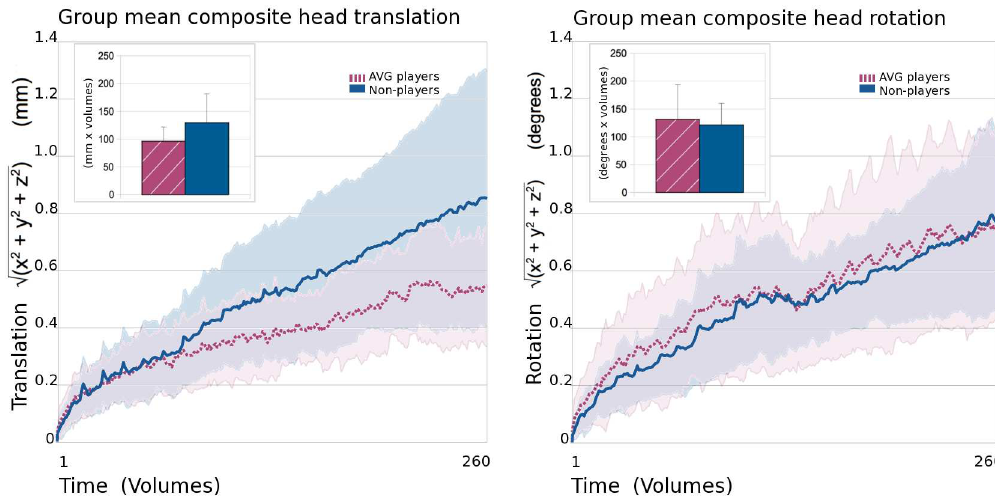
Fig 2. Translational and rotational head movement. Group mean composite (x, y, and z directions) translational head motion (left panel) and rotational head motion (right panel). Data from the action video game (AVG) player group are represented by dashed burgundy lines and non-player data are represented by solid blue lines. Standard deviations are shown in paler colours around main plotted lines. Comparisons of estimates of area under the curve (using Riemann sums) for the gamer (hatched burgundy) and non-gamer (blue) groups are shown inset at the top left of each panel. Error bars represent standard deviation. No significant group differences in area under the curve were detected indicating that the overall amount of head motion in the scanner did not significantly differ between the AVG player and non-player